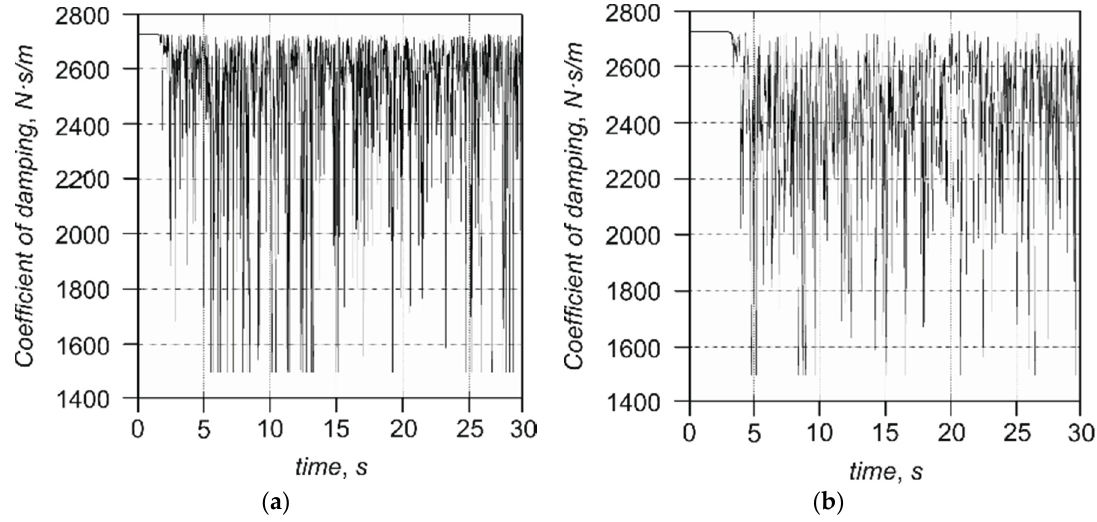
Figure 8. Coefficients of damping ( h SF 1 ) with optimized damping law dependencies, over time: ( a ) for road no. 6, P 0 = 5765, P 1 = − 19, P 2 = 0.5; ( b ) for road no. 3; P 0 = 5050, P 1 = 30, P 2 = 0.45.